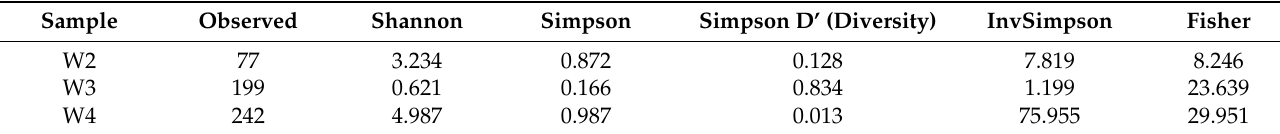
Table 4. Sequence alpha diversity and richness estimators of microbial communities.